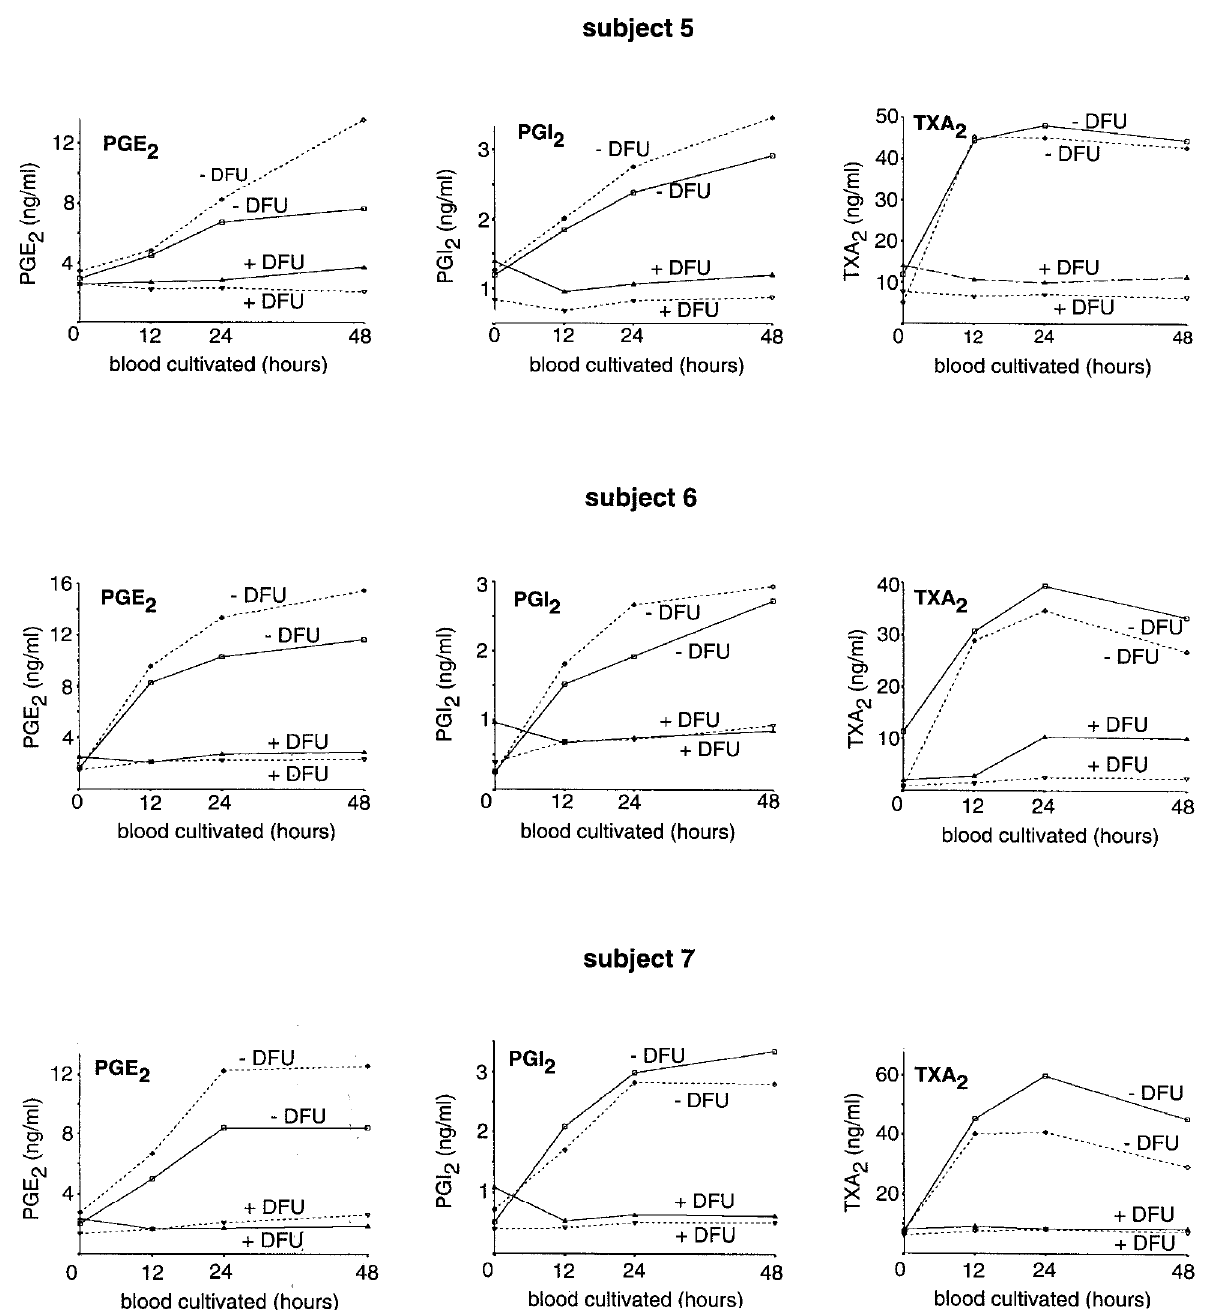
FIG. 3. The effect of ingestion of 80mg aspirin on the production of prostanoid E 2 (PGE 2 ), prostanoid I 2 (PGI 2 ) and thromboxane A 2 (TXA 2 ) in lipopolysaccharide (LPS)-stimulated blood cultures, measured in the absence and presence of the cyclo- oxygenase-2 inhibitor DFU. LPS-stimulated blood cultures of subjects 5, 6 and 7 were prepared without and with DFU (10 m M in dimethylsulfoxide) before and 24h after intake of 80mg aspirin. Prostanoids in culture supernatants were extracted by absorption on C 18 -cartridges and eluation with absolute ethanol, and determined by immunoassays. Solid lines, prostanoid values (ng/ml) before aspirin intake; dashed lines, prostanoid values (ng/ml) after aspirin